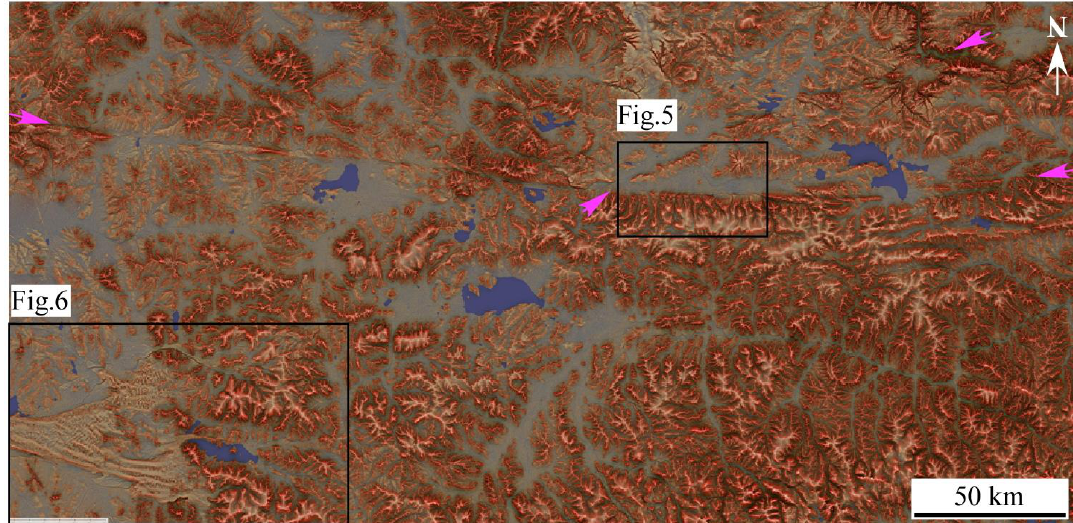
Figure 3. Topographical features along Bulnay fault. Pink arrows indicate fault lines.